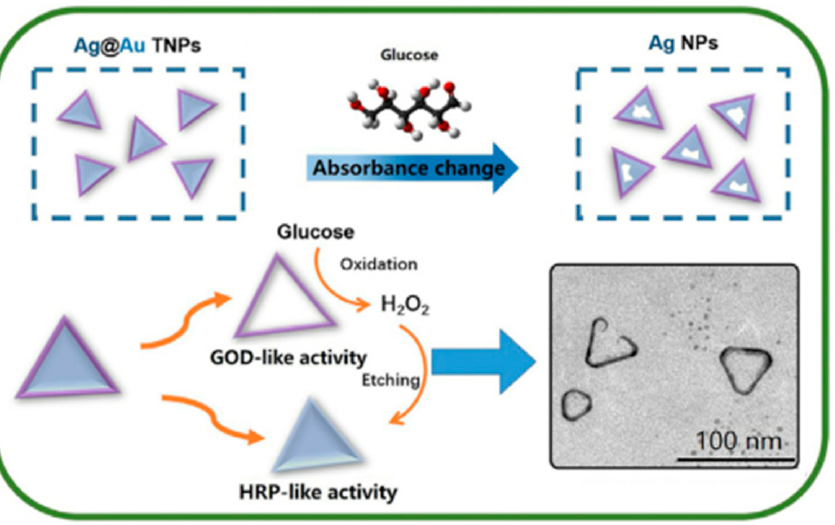
Figure 11. Schematic illustration of the colorimetric detection of glucose based on Ag@Au core/shell TNPs. Reprinted with permission from Ref. [102], Copyright 2019, Elsevier.